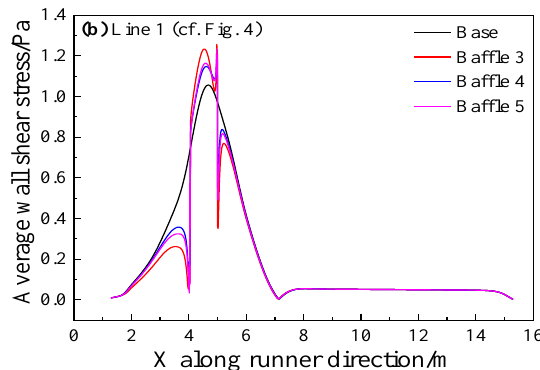
Figure 25. Time-averaged wall shear stress of the different main troughs at two lines: ( a ) Line 2; and ( b ) Line 1.